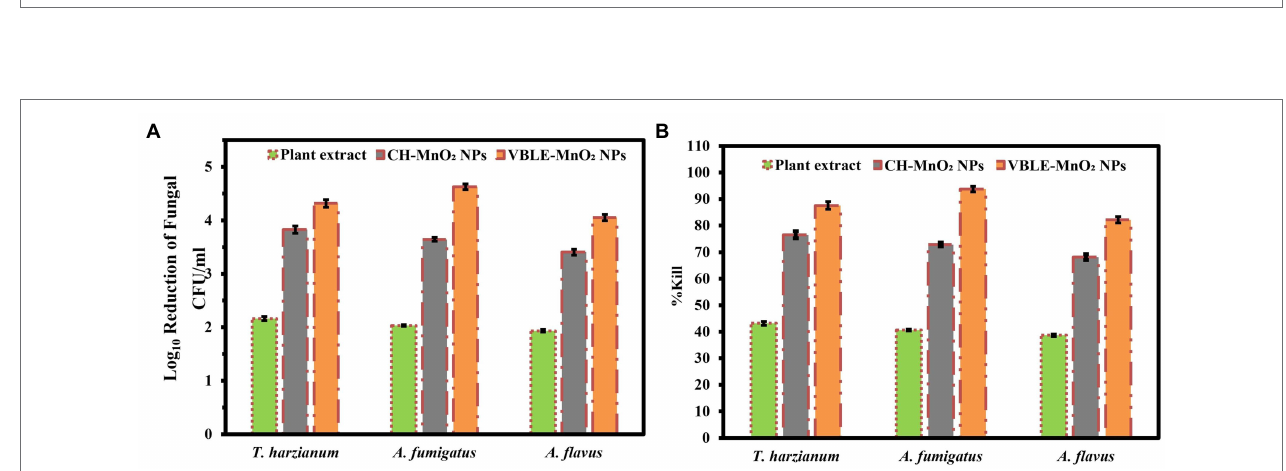
FIGURE 7 | Antifungal activity of VBLE-MnO 2 NPs in terms of (A) log 10 reduction and (B) % killing efficiency of fungal strains in comparison with leaves extract of V. betonicifolia and CH-MnO 2